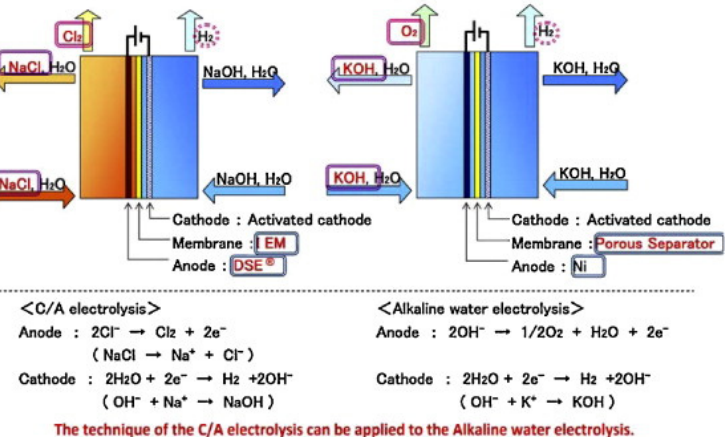
Figure 2. Schemes for AEL, alkaline electrolysis [20,21]. Reprinted with permission from [20]